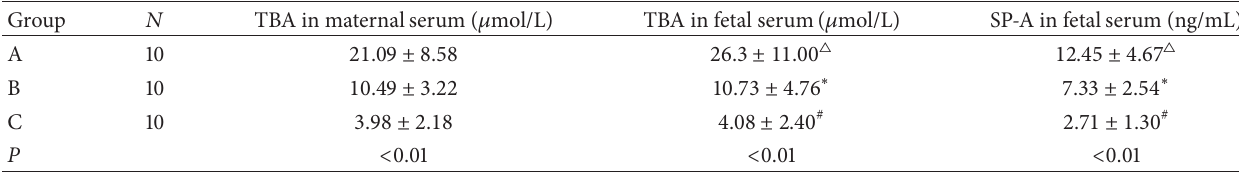
Table 3: The levels of TBA and SP-A in fetal serum of three groups (𝑥 ± s ).